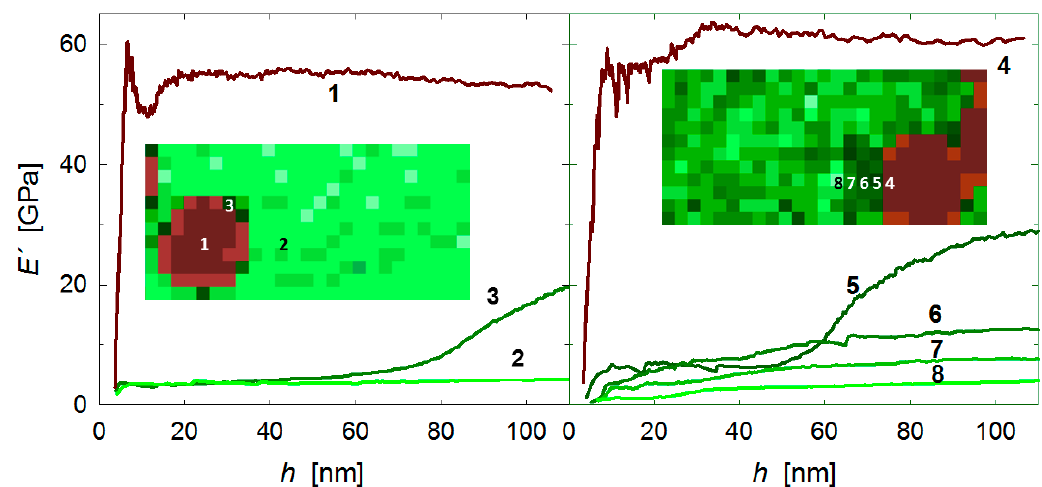
Figure 7. Storage modulus E’ as a function of indenter displacement h for specific locations identified by numbers on the PEEK/CF ( Left ) and the PEEK-GSPEEK/CF ( Right ) laminates.